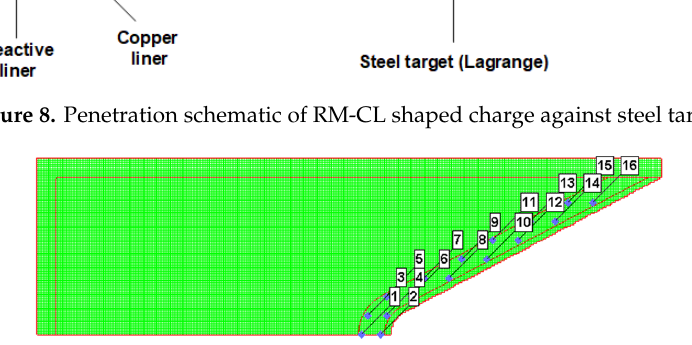
Figure 9. Gauge point location for the reactive liner. Table 2. Material strength models and EOSs of each part of RM-CL shaped charge.